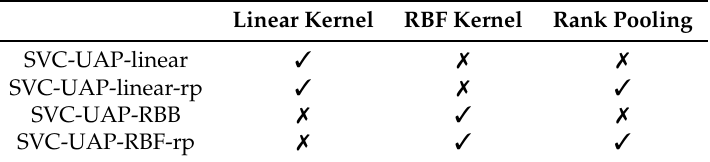
Table 1. Variants of our SVC-UAP method used in the experiments. Linear Kernel RBF Kernel Rank Pooling